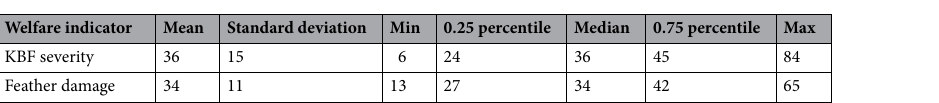
Table 1. Descriptive statistics of the KBF severity and the feather damage scores assessed at 60 WOA on the 80 hens used in the models.